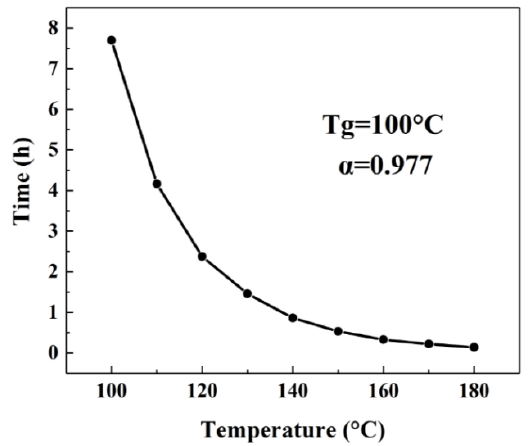
Figure 4. DiBenedetto equation fitting curves of the relationship between α and T g of ( a ) the unfilled matrix resin and ( b ) Ag-filled ICA.